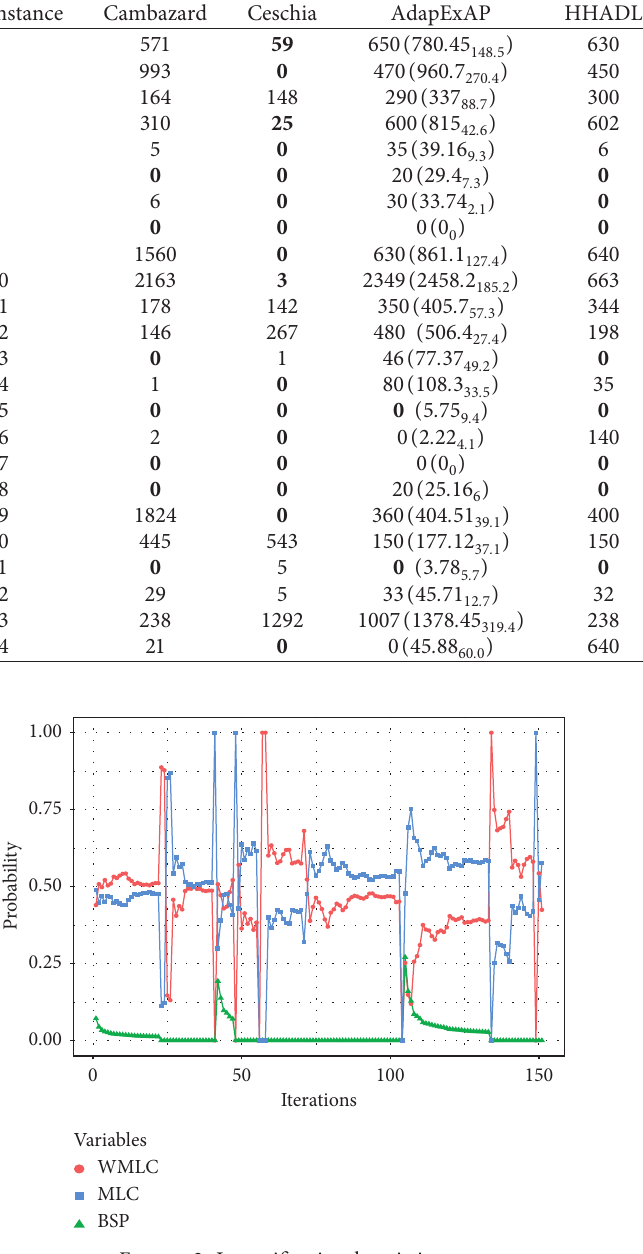
Figure 2: Intensification